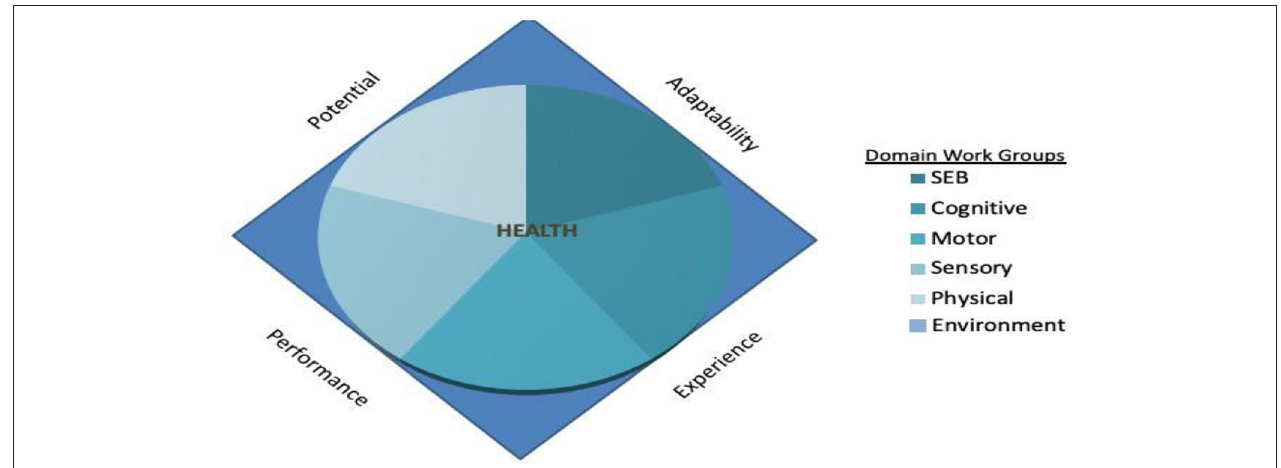
FIGURE 3 | Domain Working Groups (DWG) developed specific measures in the context of the four dimensions of health measurement so that a functional continuity could be established through mapping from single measurements into higher order descriptions.